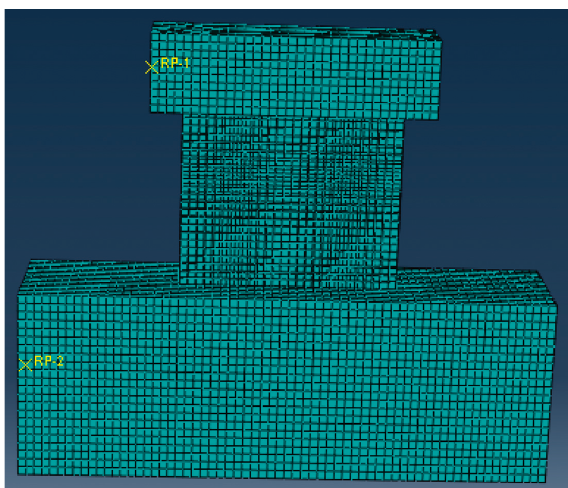
Figure 14: FE model of DSCW-3.